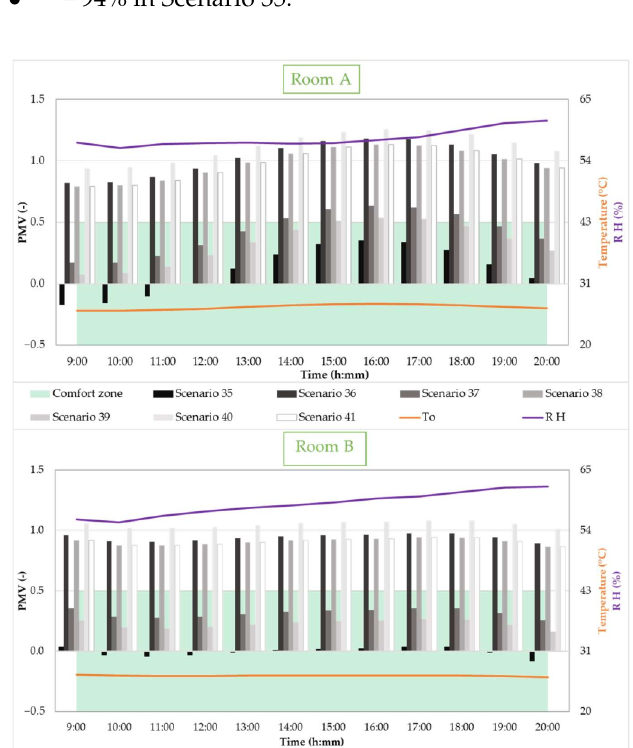
Figure 12. Hourly operative temperature, relative humidity, and PMV in rooms A and B with an out-of-bed patient: different scenarios in the summer